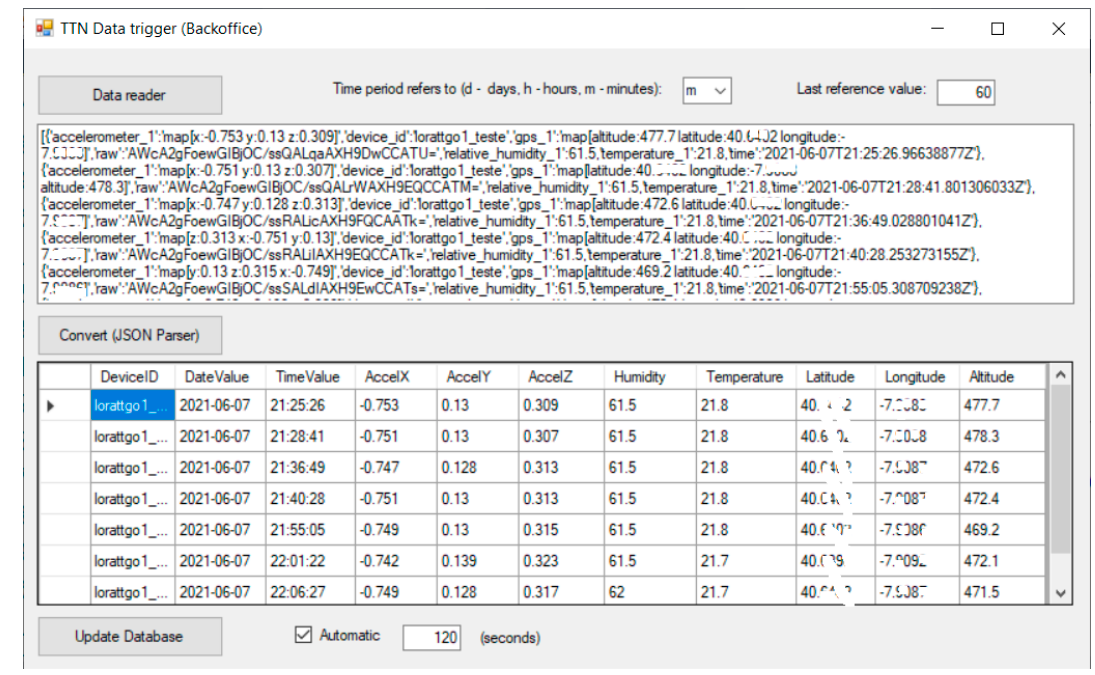
Figure 7. Example of the result obtained in the query from our C# standalone application, in JSON format.